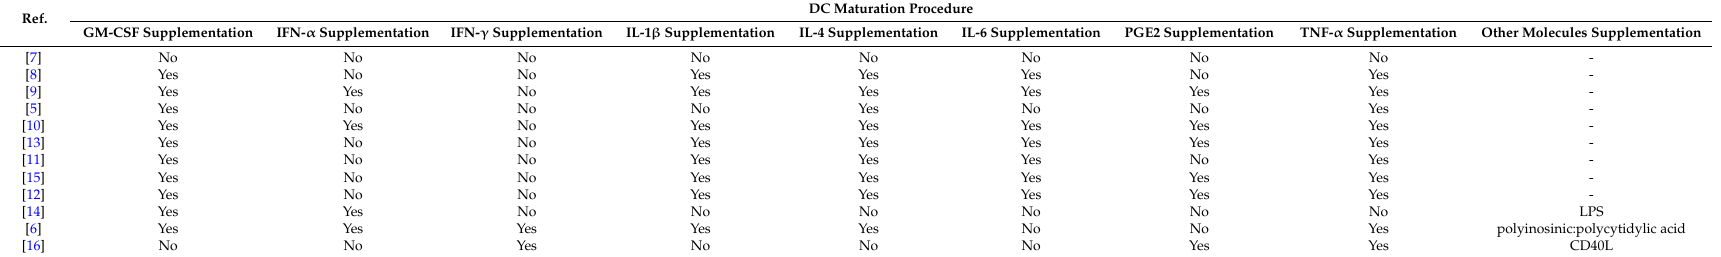
Table 4. Summary of cytokine supplementation of the protocols of the 12 studies that were included in the meta-analysis.